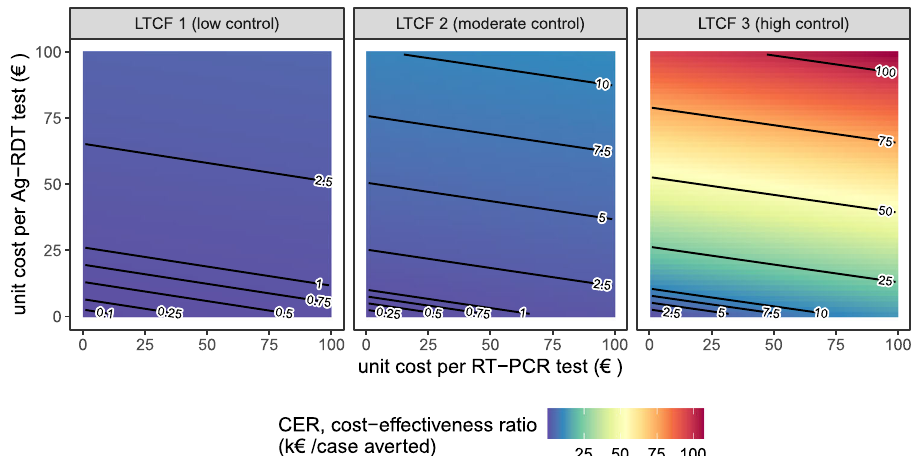
Fig. 4 Surveillance cost-effectiveness: underlying outbreak risk outweighs testing unit costs. Mean cost-effectiveness ratios for a highly epidemiologically effective surveillance strategy (intervention #23, routine RT-PCR testing + 2-round Ag-RDT screening on days 1 and 5), estimated as testing unit costs per infection averted while varying unit costs for RT-PCR tests ( x -axis) and Ag-RDT tests ( y -axis). Baseline assumptions underlying simulations include: “ low ” community SARS-CoV-2 incidence; time-varying Ag-RDT sensitivity relative to RT-PCR (Ag-RDT A); and screening interventions that target all patients and staff in the LTCF. RT-PCR = reverse transcriptase polymerase chain reaction; Ag-RDT = antigen rapid diagnostic testing; LTCF = long-term care